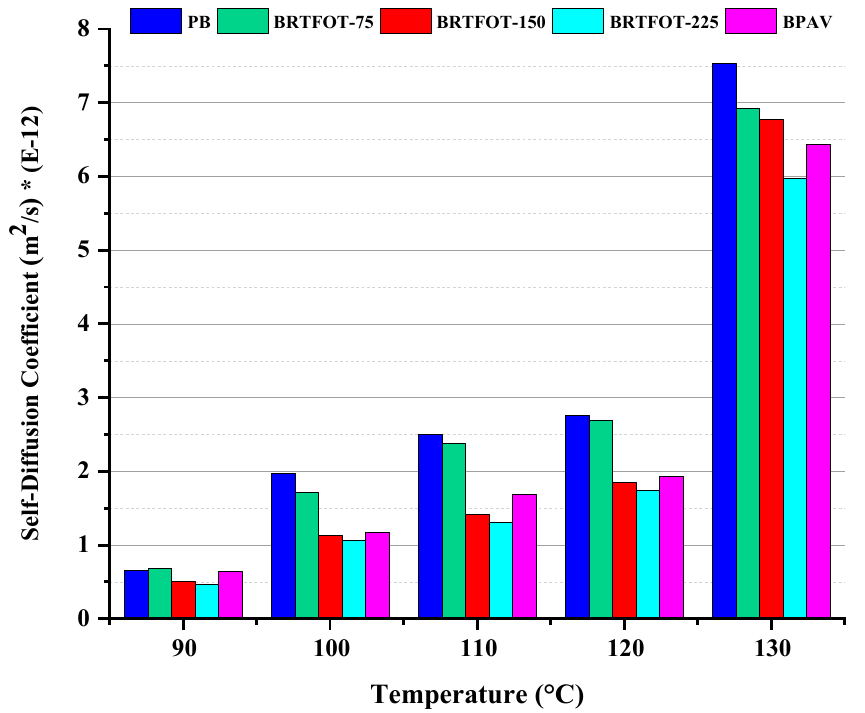
Figure 6. NMR self-diffusion coefficient characterization in the temperature range 90–130 °C for the different samples (PB, BRTFOT-75, BRTFOT-150, BRTFOT-225, and BPAV).